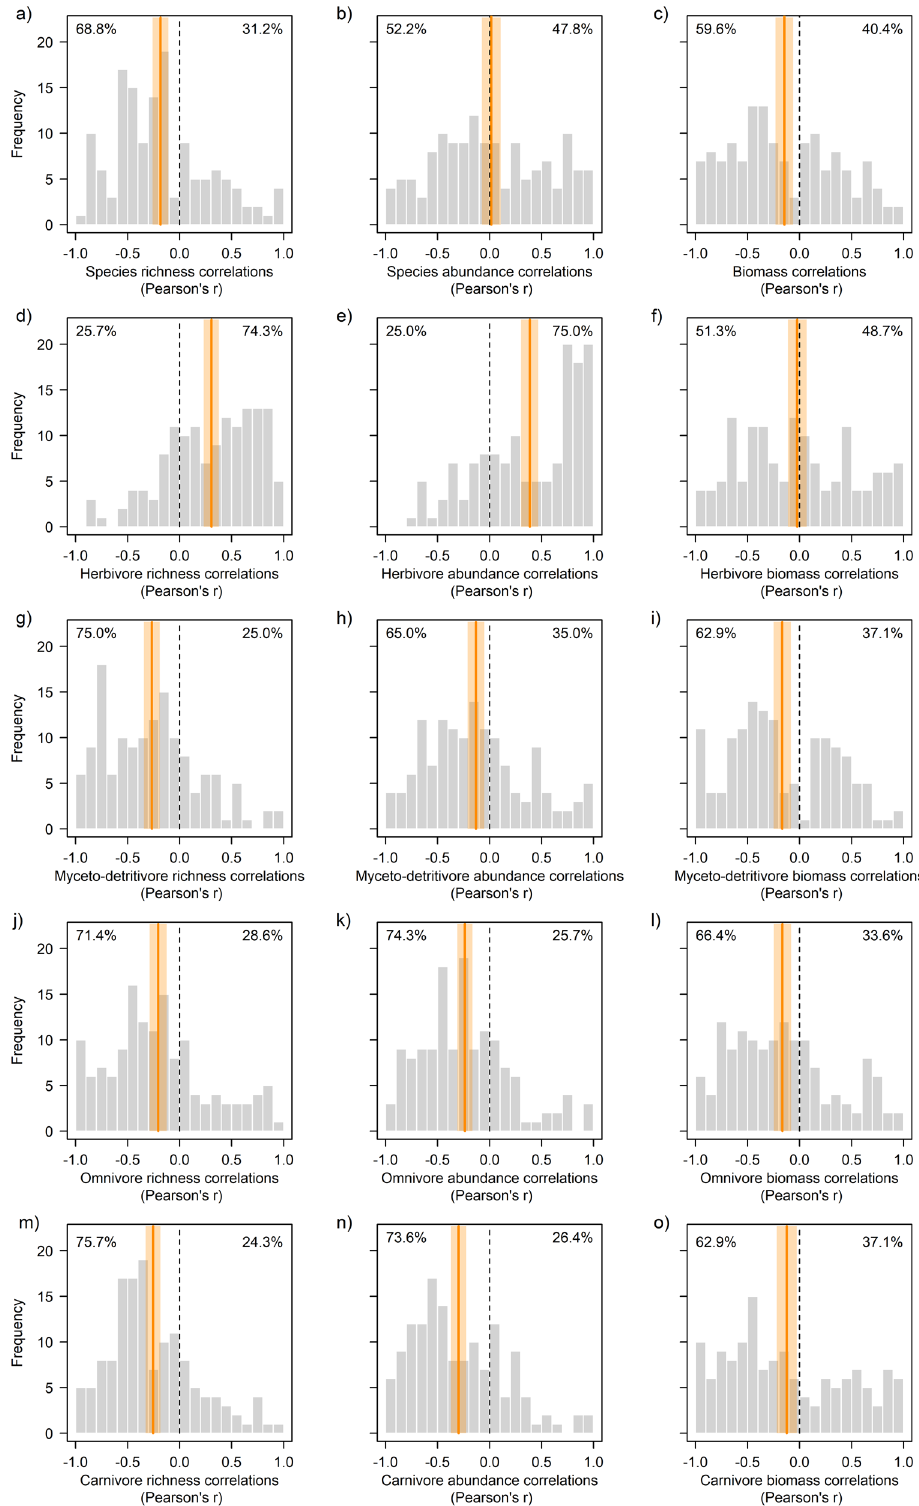
Fig. 1 Distribution of site-level correlations. Shown is Pearson ’ s r between year and the respective community response in species richness (left column), abundance (middle column), and biomass (right column) for a – c the total insect community, d – f herbivores, g – i myceto-detritivores, j – l omnivores, and m – o carnivores. Bold vertical lines indicate average correlations (95% in shaded polygons). Correlations were negative on average with the exception of positive average correlations for herbivore species richness and abundance, while for total abundance and herbivore biomass 95% CI overlapped with null. Dashed vertical lines mark null with negative values indicating sites with declining and positive values sites with increasing community responses over time. Numerical details are reported in Supplementary Table 2. Percentages in each panel give the proportion of sites with negative (left) and positive (right)